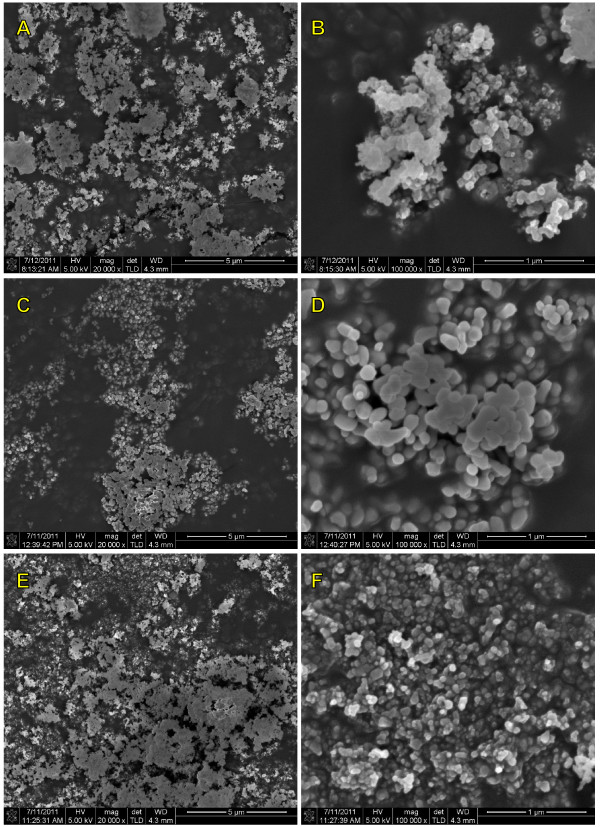
SEM images of used nanopowders. (A, B) Y2O3, (C, D) Y3Al5O12, (E, F) MgAl2O4.